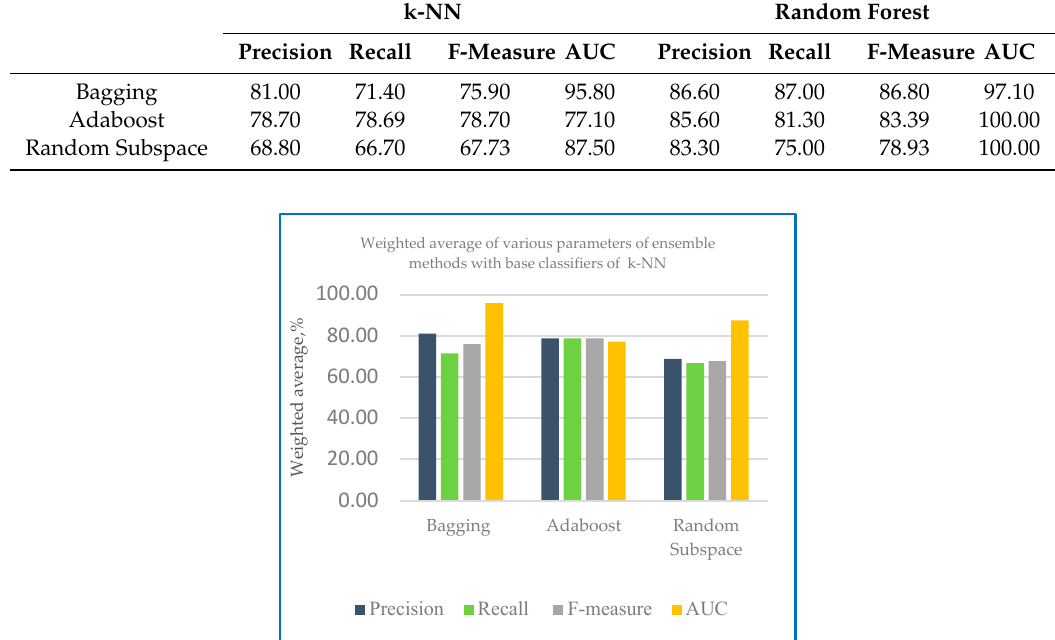
Table 4. Performance measures with base classifiers of k-NN and RF on holdout method.